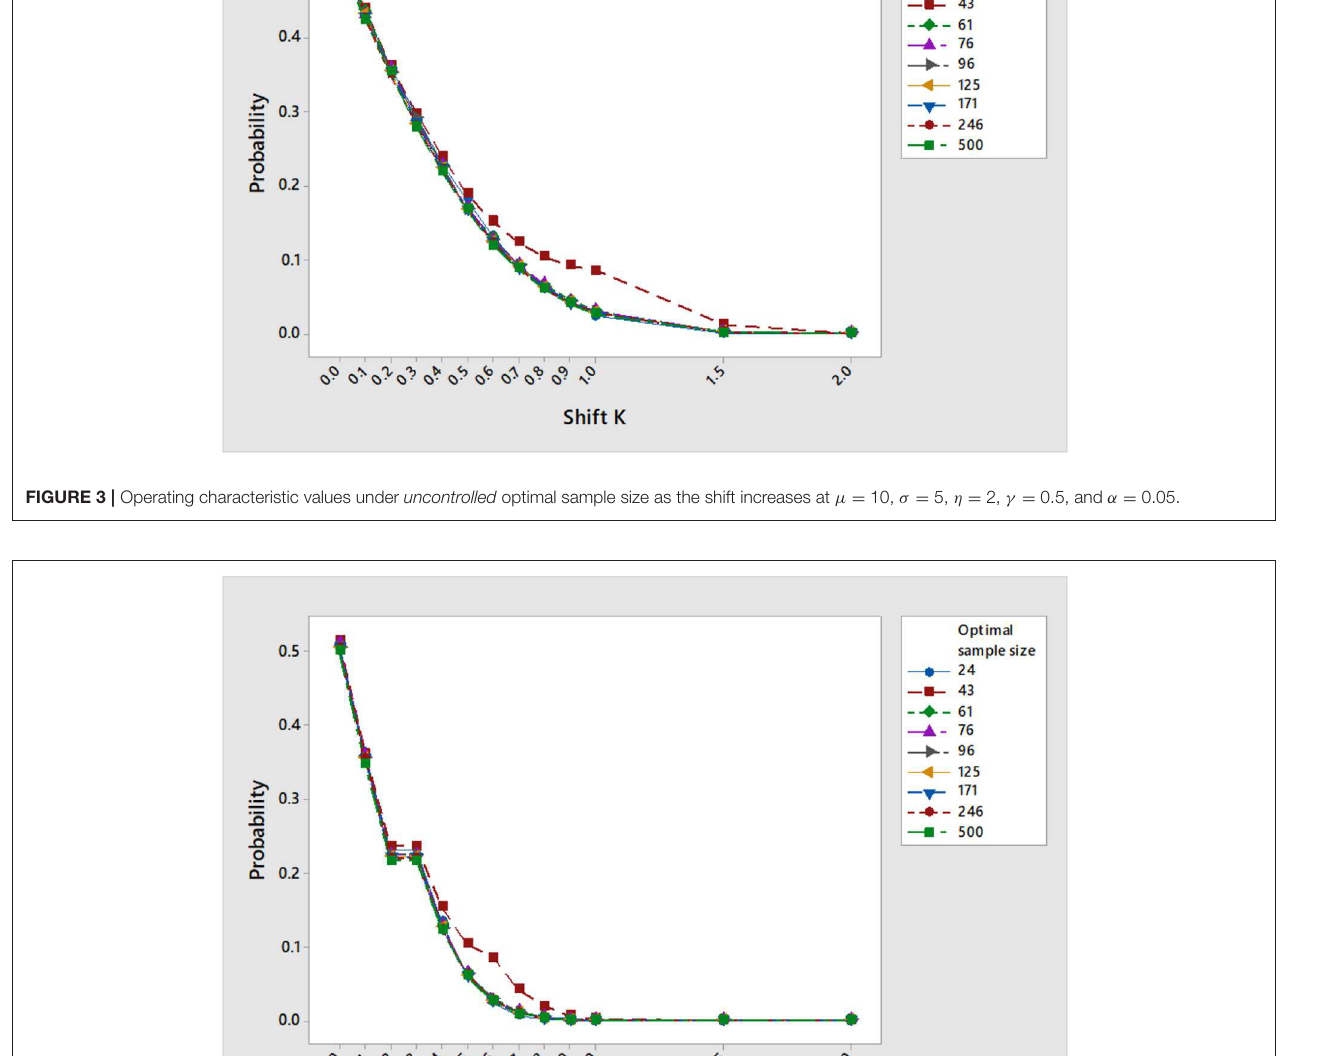
FIGURE 4 | Operating characteristic values under controlled optimal sample size as the shift increases at µ